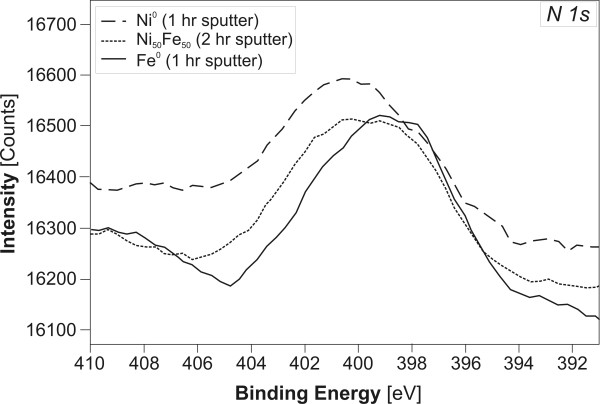
N 1 s peaks centered around 400 eV documenting the presence of N in the tested alloys and metals after sputtering with Ar+ (Ni0 400.1 eV, Ni50Fe50 399.7 eV, Fe0 398.9 eV).